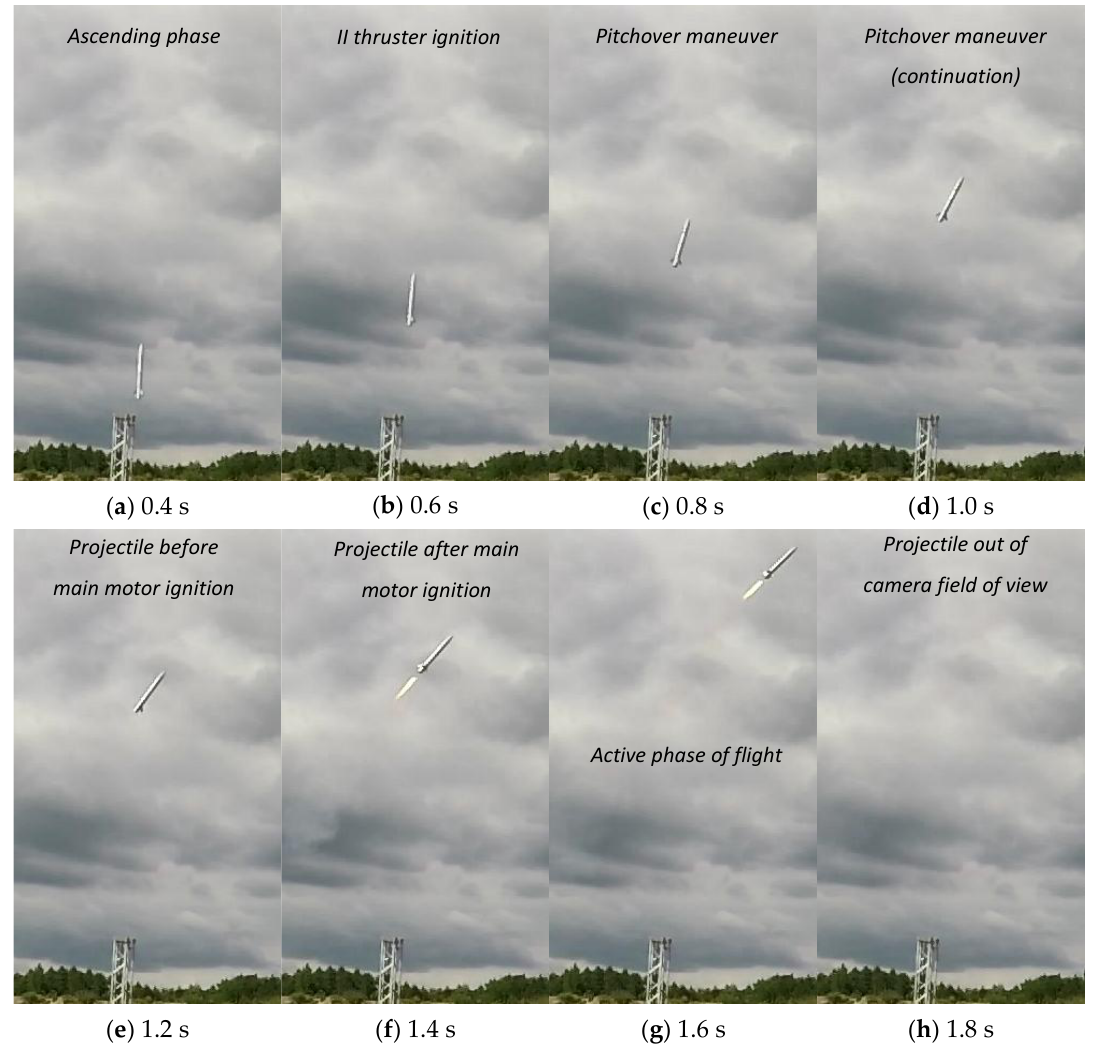
Figure 25. The launch phase of the missile (test 5, lateral thrusters behind the center of mass).